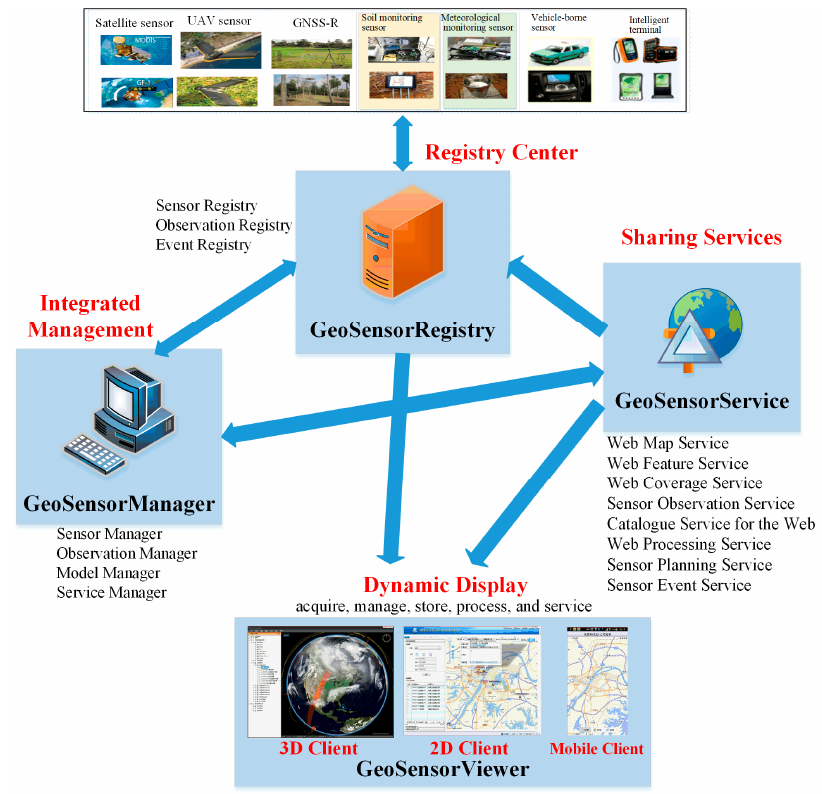
Figure 5. The components of the GeoSensor.